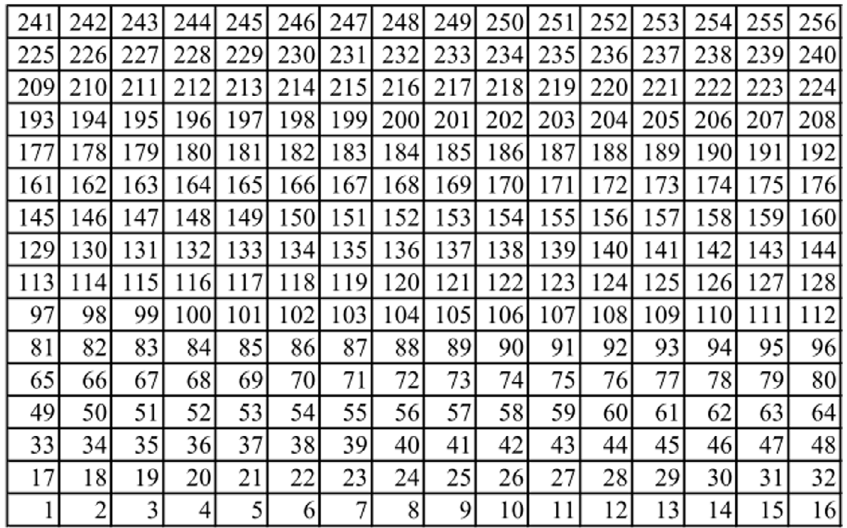
Fig. 2. Fuel assembly pin identi fi cation.